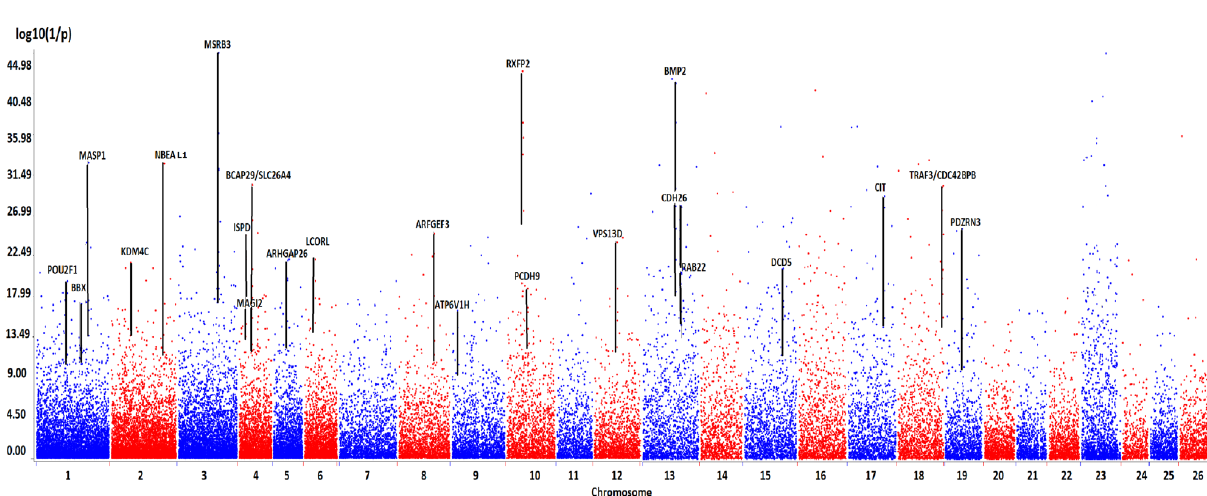
Figure 6. Sheep cradles analyses as a function of environmental variables. ( 1 ) Mapping display of the cradles coloured according to the result of the clustering. ( 2 ) HCPC analysis. (a) Scree plot. (b) PCA correlation circle. (c) PCA score plot of goat cradles. Colours represent the main clusters obtained by HCPC (K = 5). PC 1 and PC 2 represent respectively principal components 1 and 2; numbers in brackets show the variance explained by each PC. ( 3 ) Boxplot representation for the variables Mean Annual Temperature, Mean Annual Precipitation and Altitude for the different HCPC groups and associated numerical values. Alt.: Altitude in meters, T°: Temperature in °C × 10, prec.: precipitation in millimeters, min.: minimal, max.: maximal, s.d.: standard deviation.